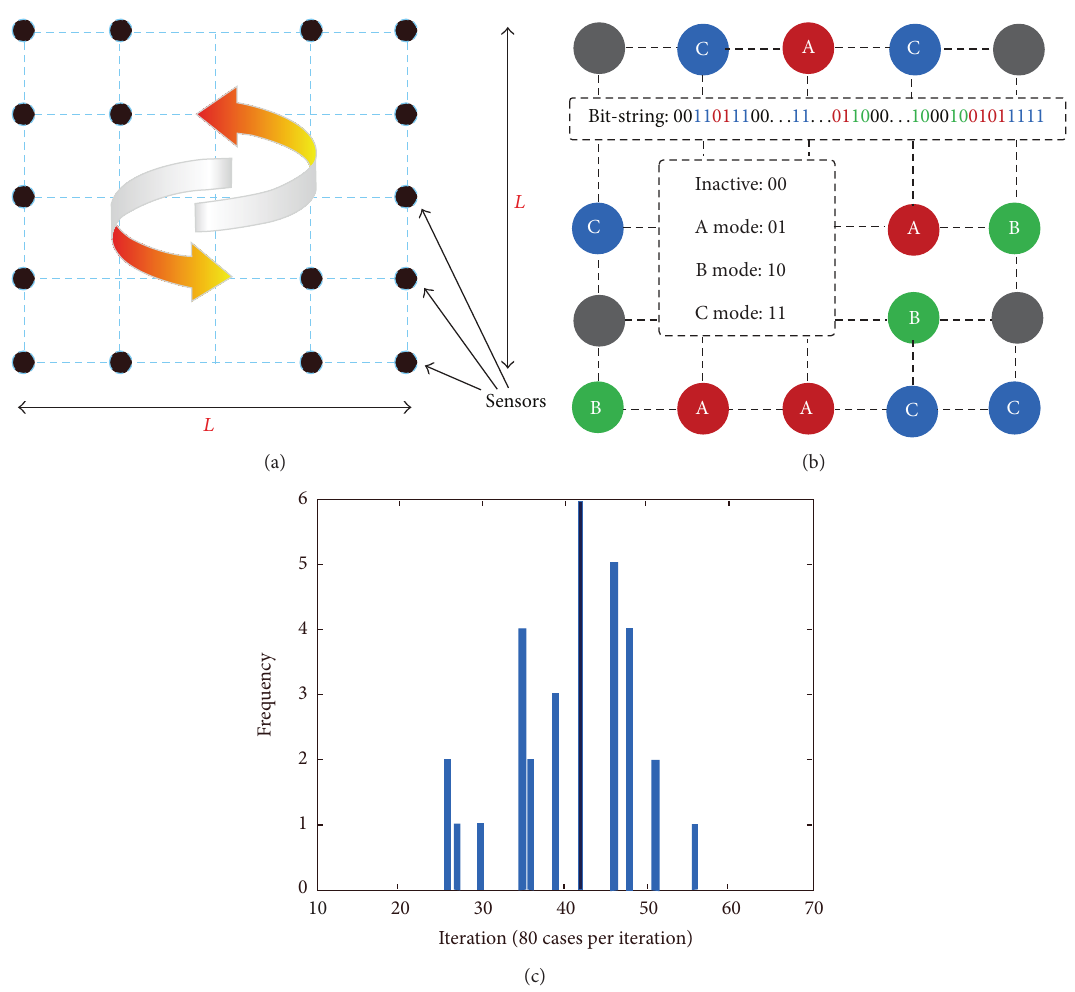
Figure 4: (a) Coverage scheme in wireless sensor network. (b) Network with represented encoding. (c) Network lifetime in specified scale.